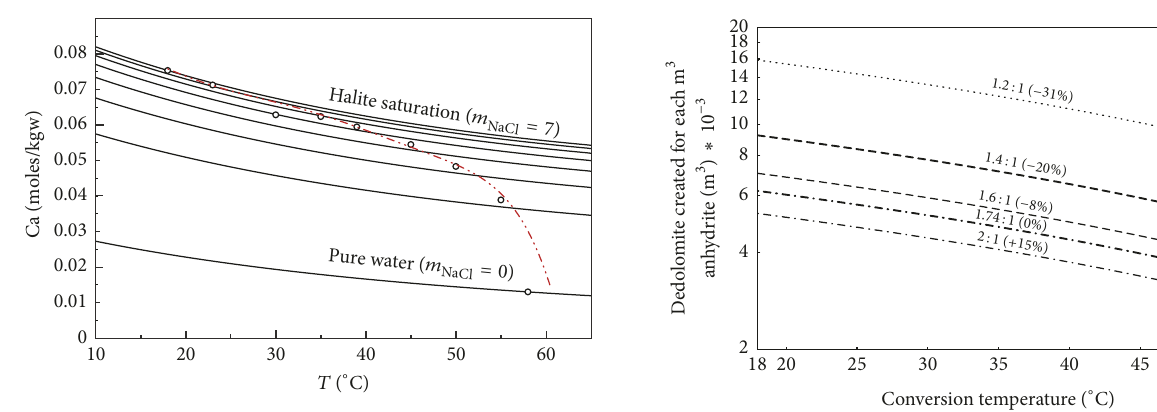
Figure 4: Simple PHREEQC batch model which predicts the solubility of anhydrite as a function of temperature and salinity at one atmosphere pressure. Each isoline represents an increase of 1 mole in salinity starting with 0 moles at the lowermost part of the figure. The points represent the anhydrite solubility under dehydration conditions as specified by Hardie [36].